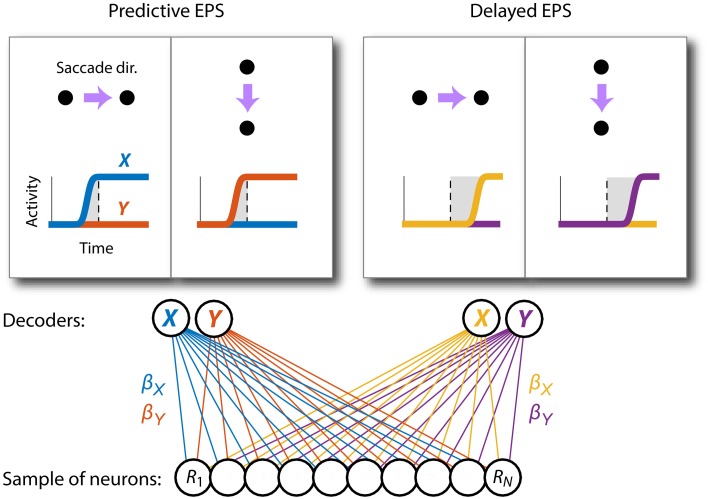
Selective pooling of neural activity generates time-lagged eye-position signals. Two über-neurons (X^ and Y^) were constructed to represent the horizontal and vertical components of eye position through their firing rates. Each took a weighted sum (with weights, βX and βY, respectively) of activity (R) across a sample of experimentally observed cortical neurons (circles). Idealized time courses for these decoder units are shown for two orthogonal saccade directions (rightward and downward). Using one set of weights (blue and red), X^ and Y^ carry a predictive representation of eye movements (the vertical dashed line indicates the actual onset of eye movement). Using a different set of weights (yellow and purple), their representation lags behinds the actual eye. Both time courses were decoded from the same spatiotemporal patterns of neural activity in the population. (Note that for the purpose of visualization, the downward saccade in this and all other figures is plotted as if it was upward).